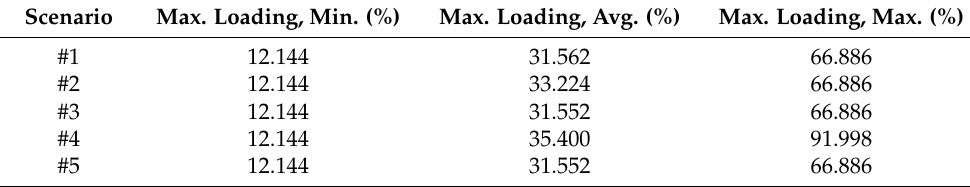
Table 4. Maximum loading along Feeder